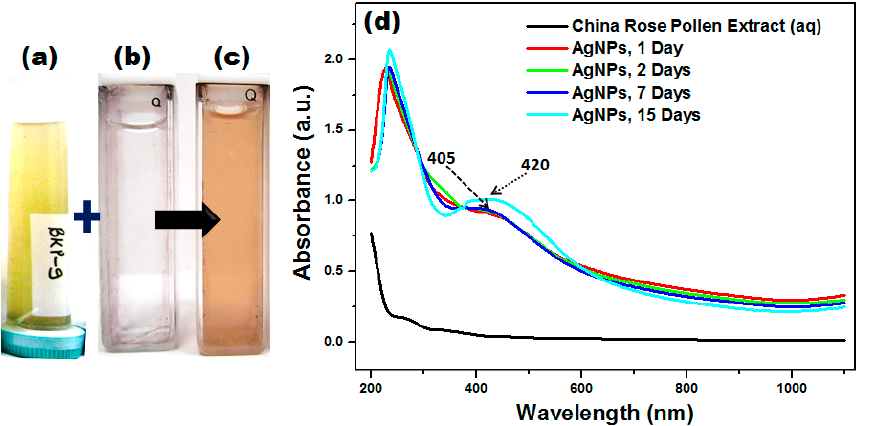
Figure 3. Visual image of ( a ) Hibiscus rosa-sinensis pollen extract, ( b ) 1 mM AgNO 3 , ( c ) as-synthesized AgNPs, and ( d ) UV–vis spectrum of as-synthesized AgNPs using Hibiscus rosa-sinensis flower